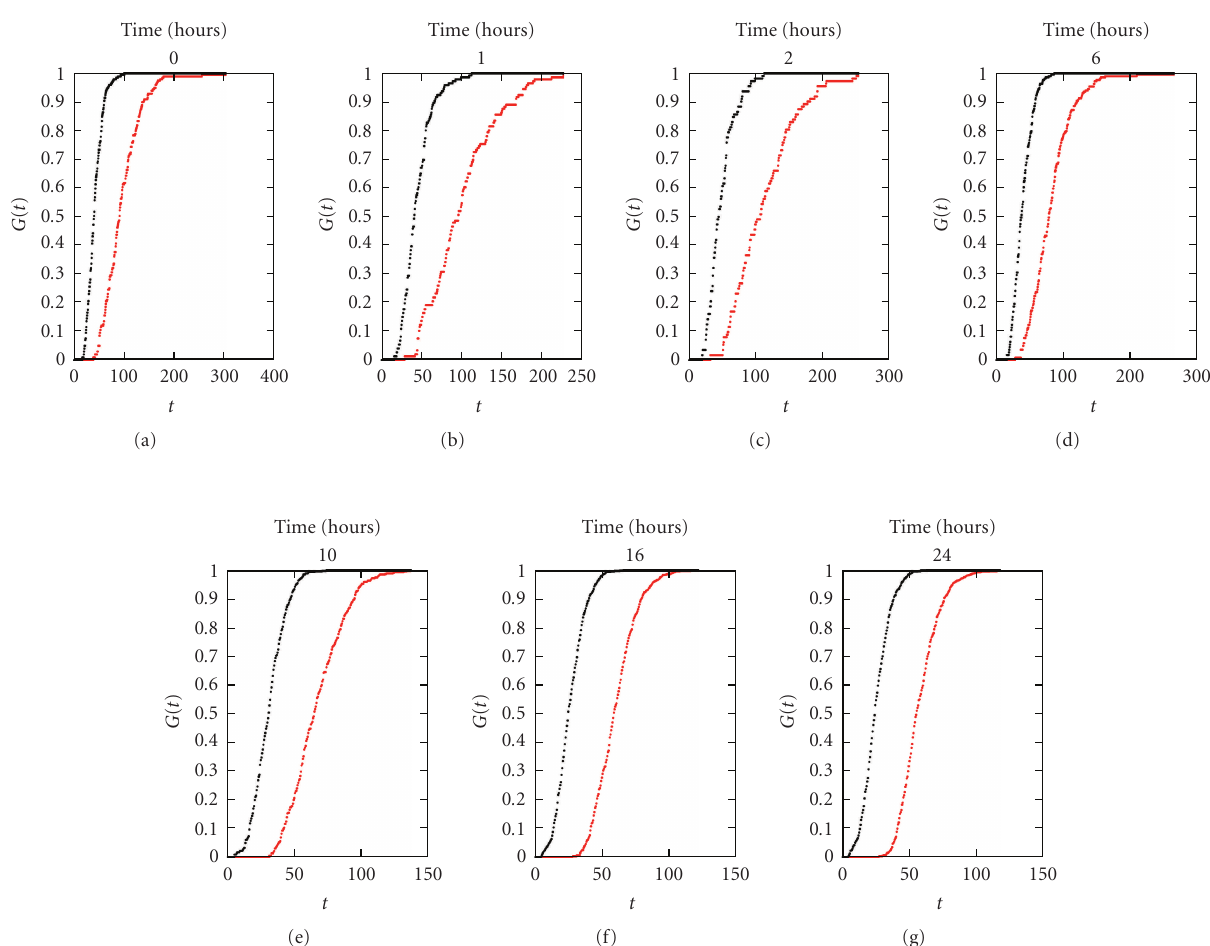
Figure 7: Point Pattern Analysis indicates that cells do not pick random locations. In order to show that cell locations obtained from segmented images are di ff erent from random scattering, we implemented CNND function G . The function G is plotted such that G ( t ) represents the fraction of the cell counts for which their nearest neighbor falls within the threshold distance t . The x -axis is the threshold value t in the distance unit and the y -axis is the value of G(t). As the threshold t increases, more and more cells have their nearest neighbor within the threshold. So, this function value always increases from 0 and finally reaches 1. The black line is a random distribution and the red line is the location of the segmented, experimental nuclei. Note that the di ff erence between random scattering and actual cell locations becomes clearer for smaller and smaller t values as the gels compact over